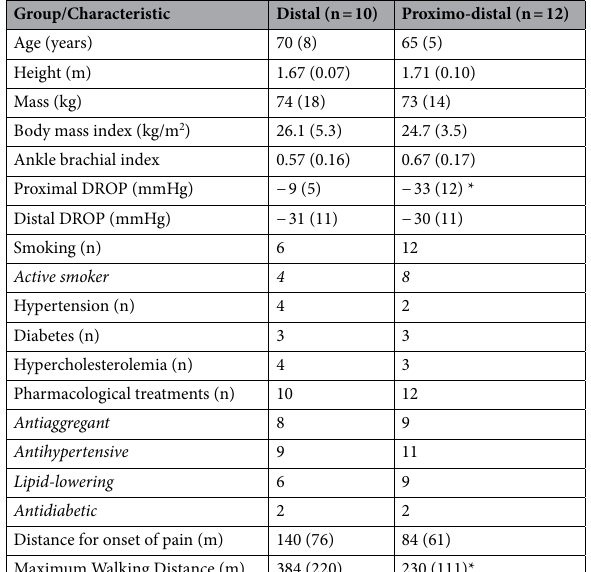
Table 1. Characteristics of the groups relative to locations of ischemia ( mean(SD) ). *P < 0.05 between distal and proximo-distal